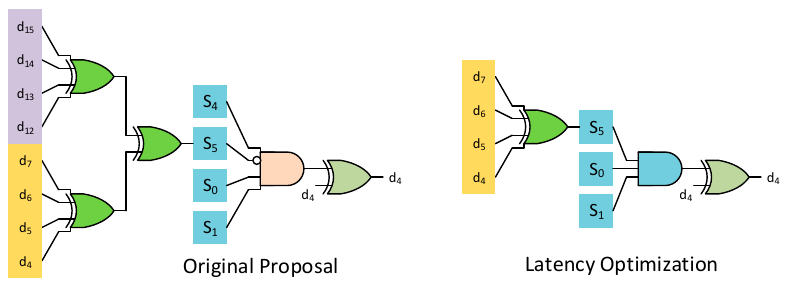
Figure 8. Parity check matrix for proposed latency optimization with four groups of four data bits each.